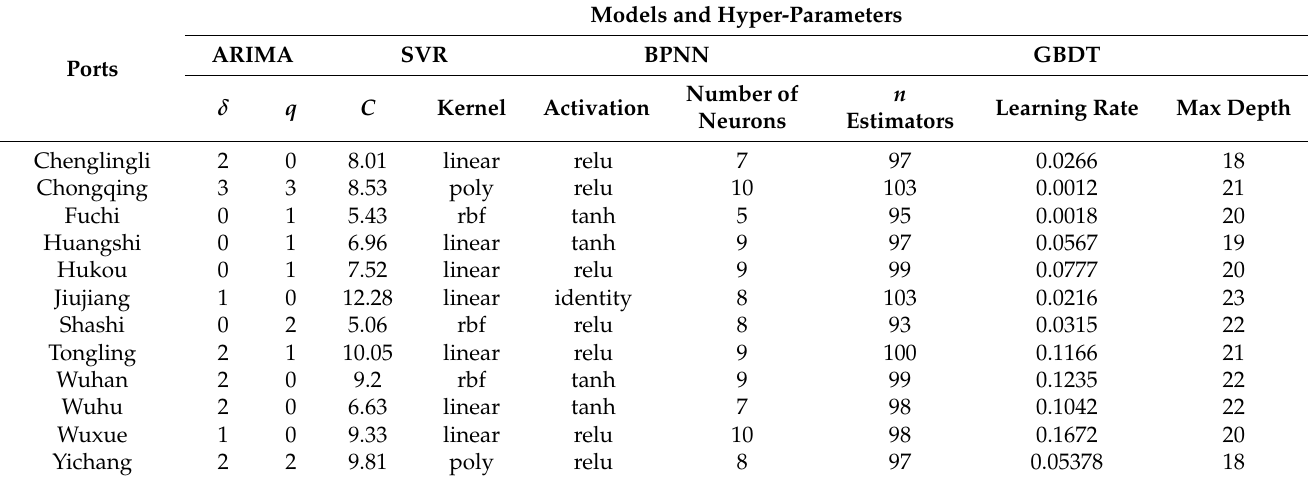
Table 3. Hyper-parameters of freight volume forecasting